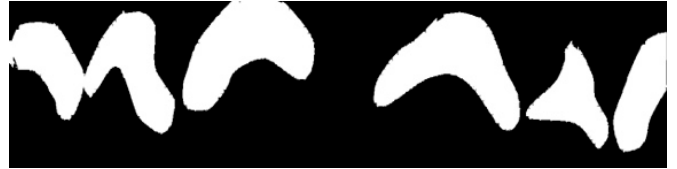
Figure 10. Shows the erosion area.